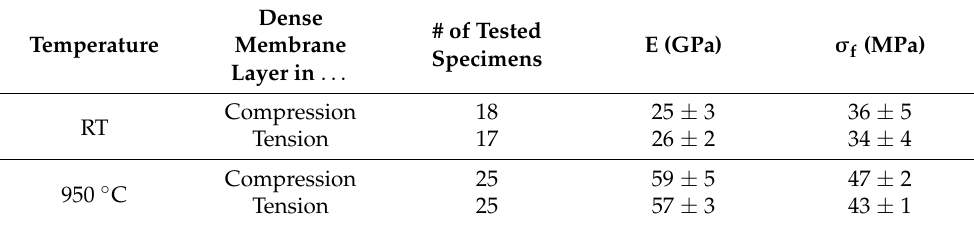
Table 4. Results of the symmetric four-point bending tests at room temperature and 950 °C.